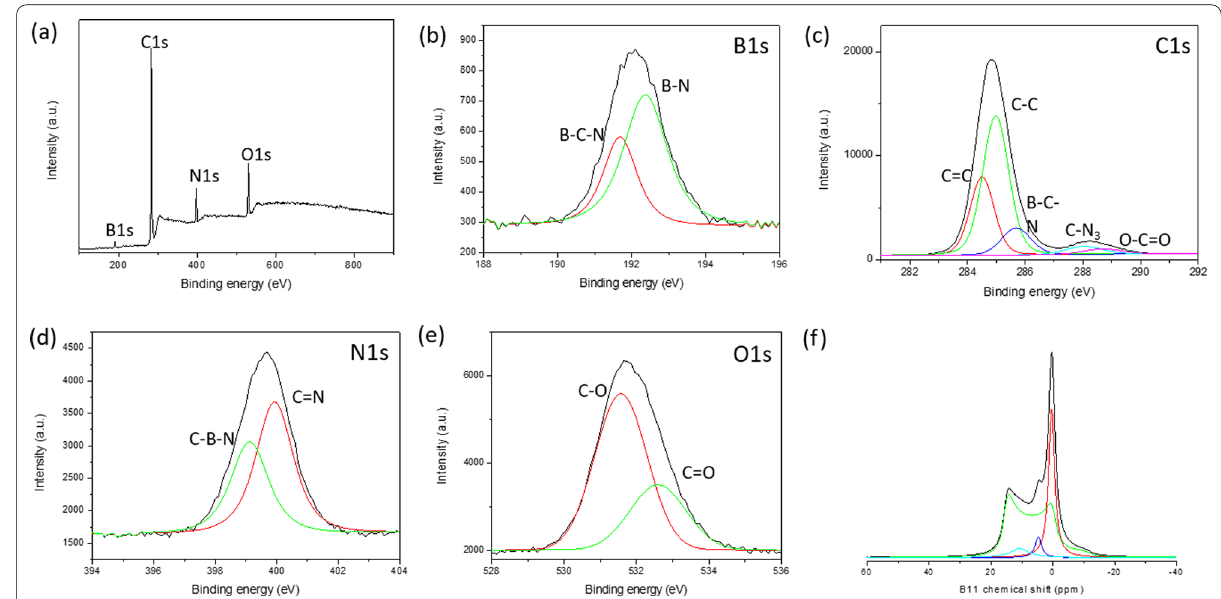
Fig. 4 a Survey XPS spectra of BMH01 and 11 B NMR spectra. Core level spectra of b B 1s , c C 1s , d N 1s , and e O 1s . Each core spectra were fitted with a black trace, while the red and green traces under the peak were deconvoluted using a Gaussian function. f 11 B solid‑state MAS NMR were deconvoluted using SOLA analysis to tricoordinate and tetracoordinate B‑sites. The XPS and 11 B solid‑state MAS NMR of other BMH series compounds can be found in Additional file 1: Figure S7, S11, and